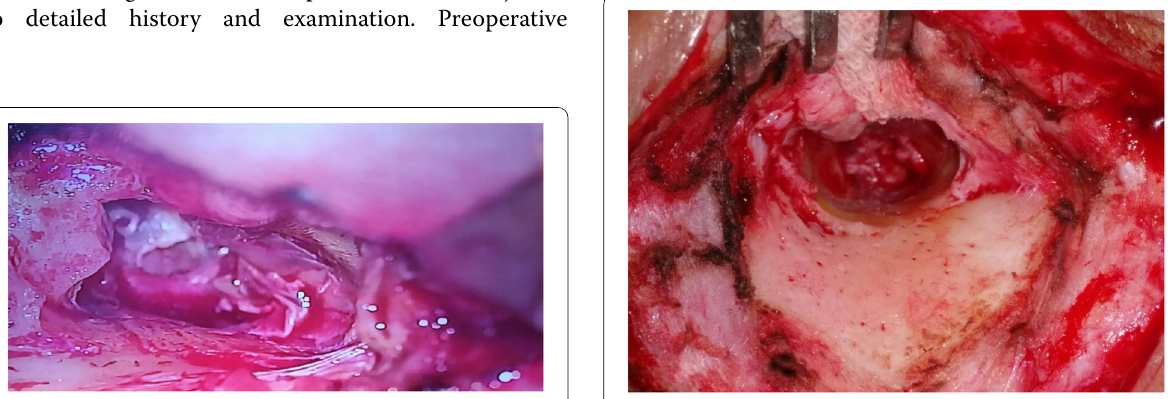
Fig. 3 Post canaloplasty picture showing inverted truncated cone appearance (right